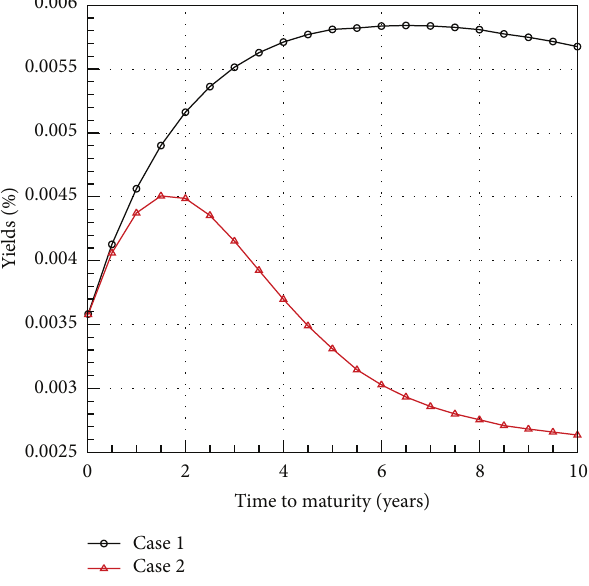
Figure 2: Yield curves (source: KIS